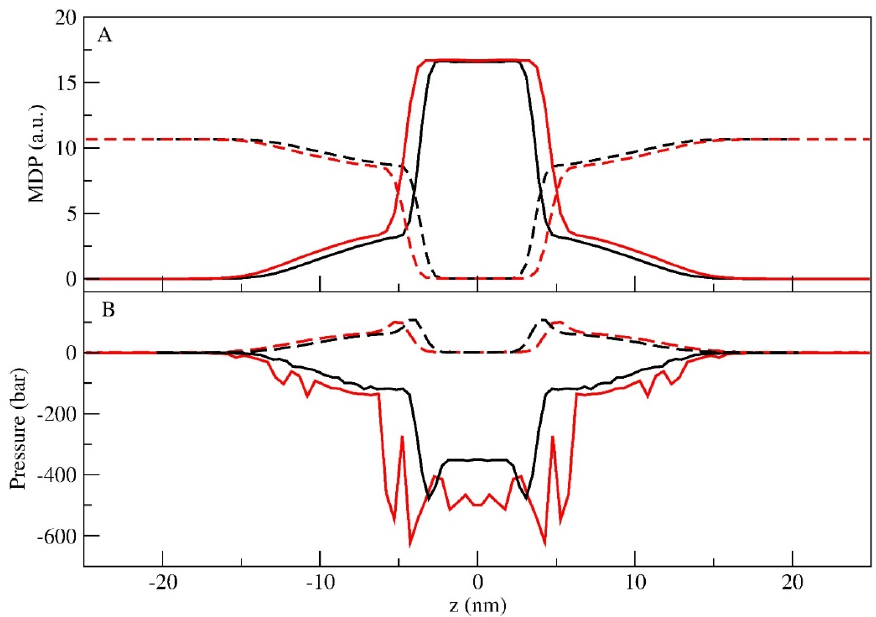
Figure 4. MDPs ( A ) and tangential pressure profiles along the z direction ( B ) for the total polymer (full line) and water (dash line). In both figures, the LS (black) and LU (red) simulations are presented.